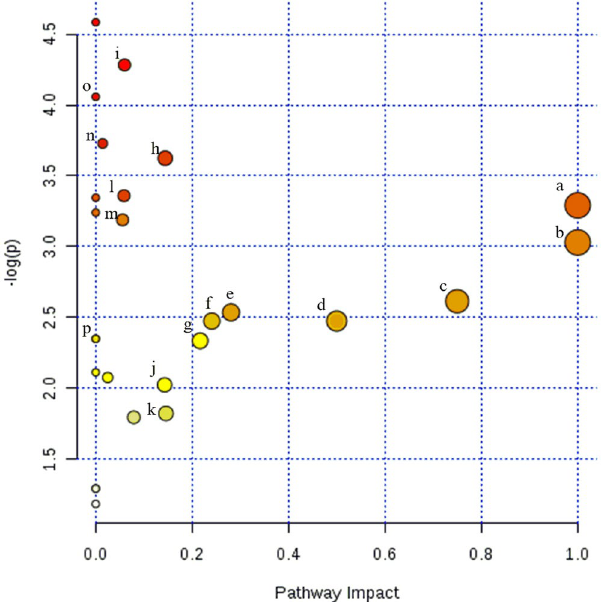
Figure 2. Ruminal metabolomics pathway analysis by MetaboAnalyst 3.0 Software on the steers with the greatest average daily gain compare to the least ADG with similar average dry matter intake according to Bos taurus KEGG pathway database. UPLC-qTOF 90 metabolites identified to differ between ADG by t-test ( P < 0.1). (a) Alpha-linolenic acid metabolism, (b) linoleic metabolism (c) taurine and hypotaurine metabolism d) phenylalanine, tyrosine and tryptophan (e) sphingolipids (f) phenylalanine (g) retinol (h) histidine (i) primary bile biosynthesis (j) glycerophospholipid (k) tyrosin (l) porphyrin and chlorophyll (m) steroid hormone biosynthesis (n) glutathione (o) Riboflavin (p) Gluconeogenesis. The darker the color and larger the size represent higher P- value from enrichment analysis and greater impact from the pathway topology analysis,